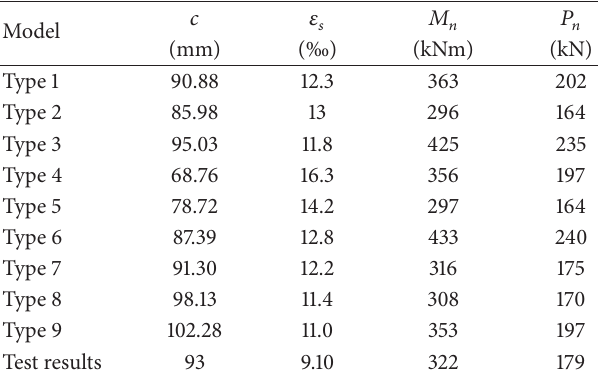
Table 4: Comparison between test results and assumed